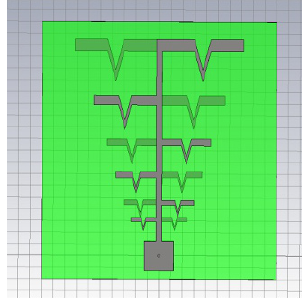
Figure 4. LPKFA with flare angle 45°.